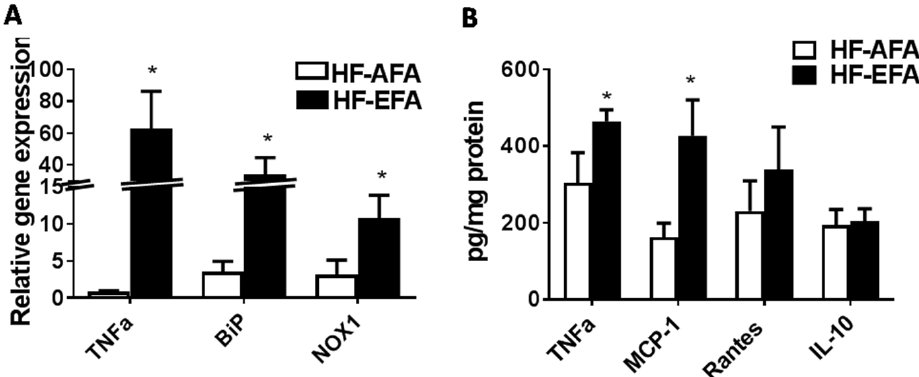
Figure 6. Inflammatory markers are increased in adipose tissue of HF ‐ EFA compared to HF ‐ AFA fed rats. ( A ) Relative mRNA levels of genes related to inflammation; and ( B ) protein levels of TNF α , MCP ‐ 1, Rantes, IL ‐ 10 in pg/mg protein, in adipose tissue of HF ‐ EFA and HF ‐ AFA fed rats. Values are means ± SEM, * p < 0.05.